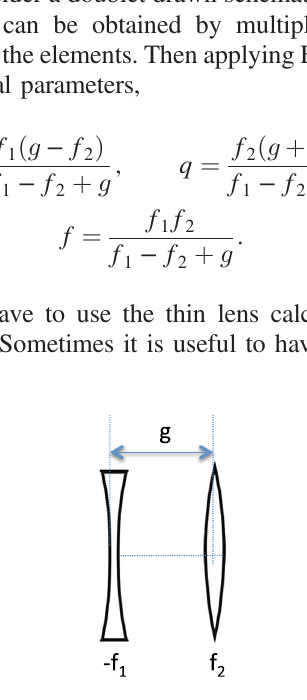
FIG. 2. A schematic layout of a doublet. f 1 of the defocusing and focusing quadrupoles respectively. g is the distance between the quadrupoles.